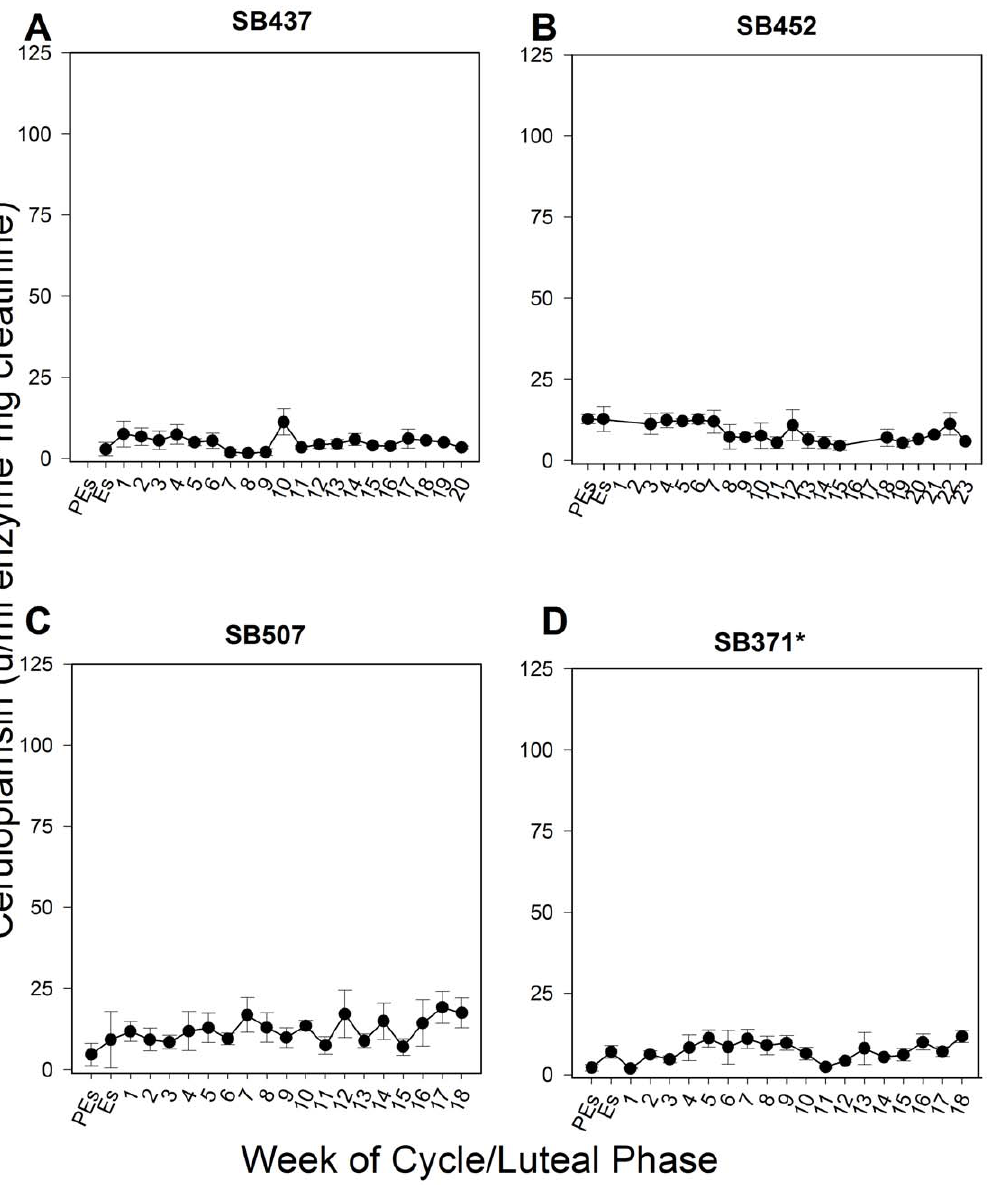
Figure 1. The levels of active ceruloplasmin in urine for female giant pandas during known pseudopregnant cycles when no breeding occurred. One known pseudopregnancy when no breeding or AI occurred is depicted for each female giant panda housed in U.S. institutions. Panel A: Known pseudopregnancy in 2002 for SB437 (SNZP). Panel B: Known pseudopregnancy in 2003 for SB452 (ZA). Panel C: Known pseudopregnancy in 2005 for SB507 (MZS). Panel D: Known pseudopregnancy in 1997 for SB371 (SDZ). Urinary progestagens were monitored in each cycle to ensure a normal luteal phase. Urine samples from every week of the reproductive cycle could not be obtained for SB452 during her known pseudopregnancy in 2003. PEs=Proestrus; Es=Estrus; Numerical numbers=weeks of the luteal phase. Variations in the x axis exist to accommodate variable concentrations and durations. Data are weekly means 6 SEM; n=4 reproductive cycles. *Samples from cycles obtained from SB371 were analyzed blind, without prior knowledge of cycle outcome.